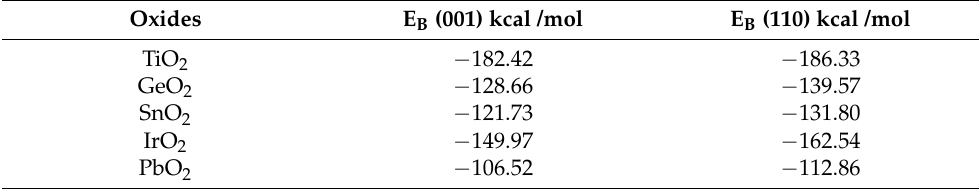
Table 3. Bonding energies for (001) and (110) planes of TiO 2 , GeO 2 , SnO 2 , IrO 2 and PbO 2